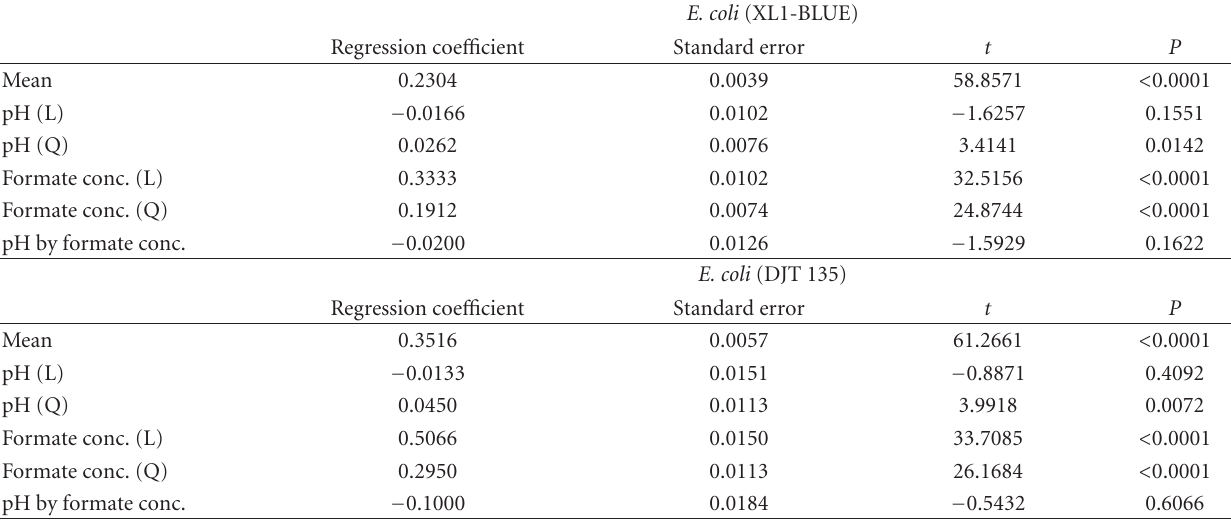
Table 3: The results of statistical analysis.